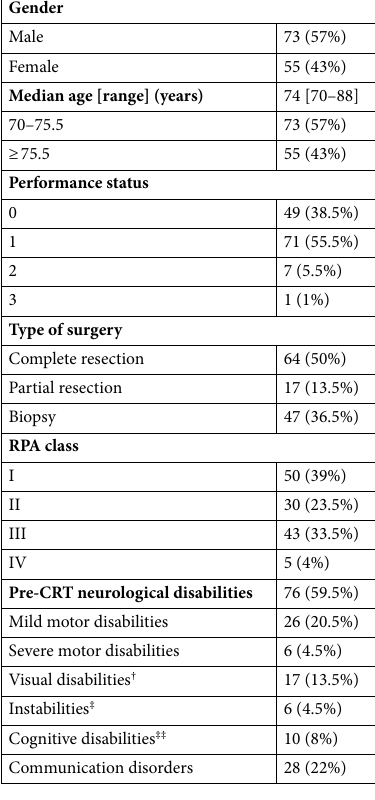
Table 1. Patient and treatment characteristics (N = 128). Several patients with pre-chemoradiation (CRT) neurological deficits had more than one disability. † E.g. homonymous hemianopias or anopsias. ‡ E.g. dizziness or proprioceptive disorders. ‡‡ E.g. disorientation with time and place, frontal syndrome, executive functioning or mnesic